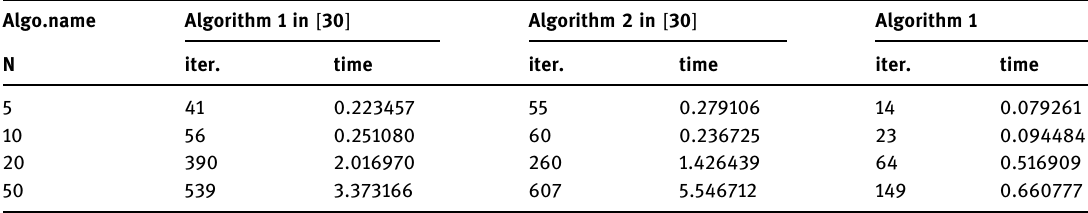
Table 1: Numerical data for Figures 1 –